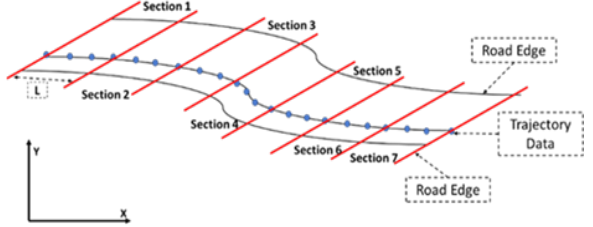
Figure 3. Presentation of the Pre-Processing